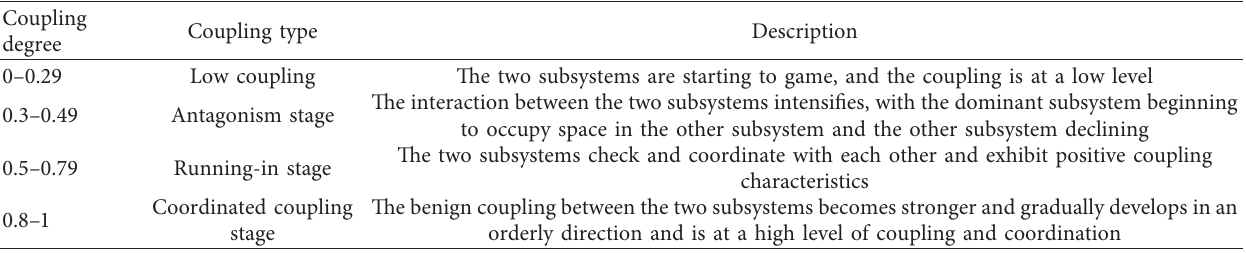
Table 2: Classification of coupling degree.